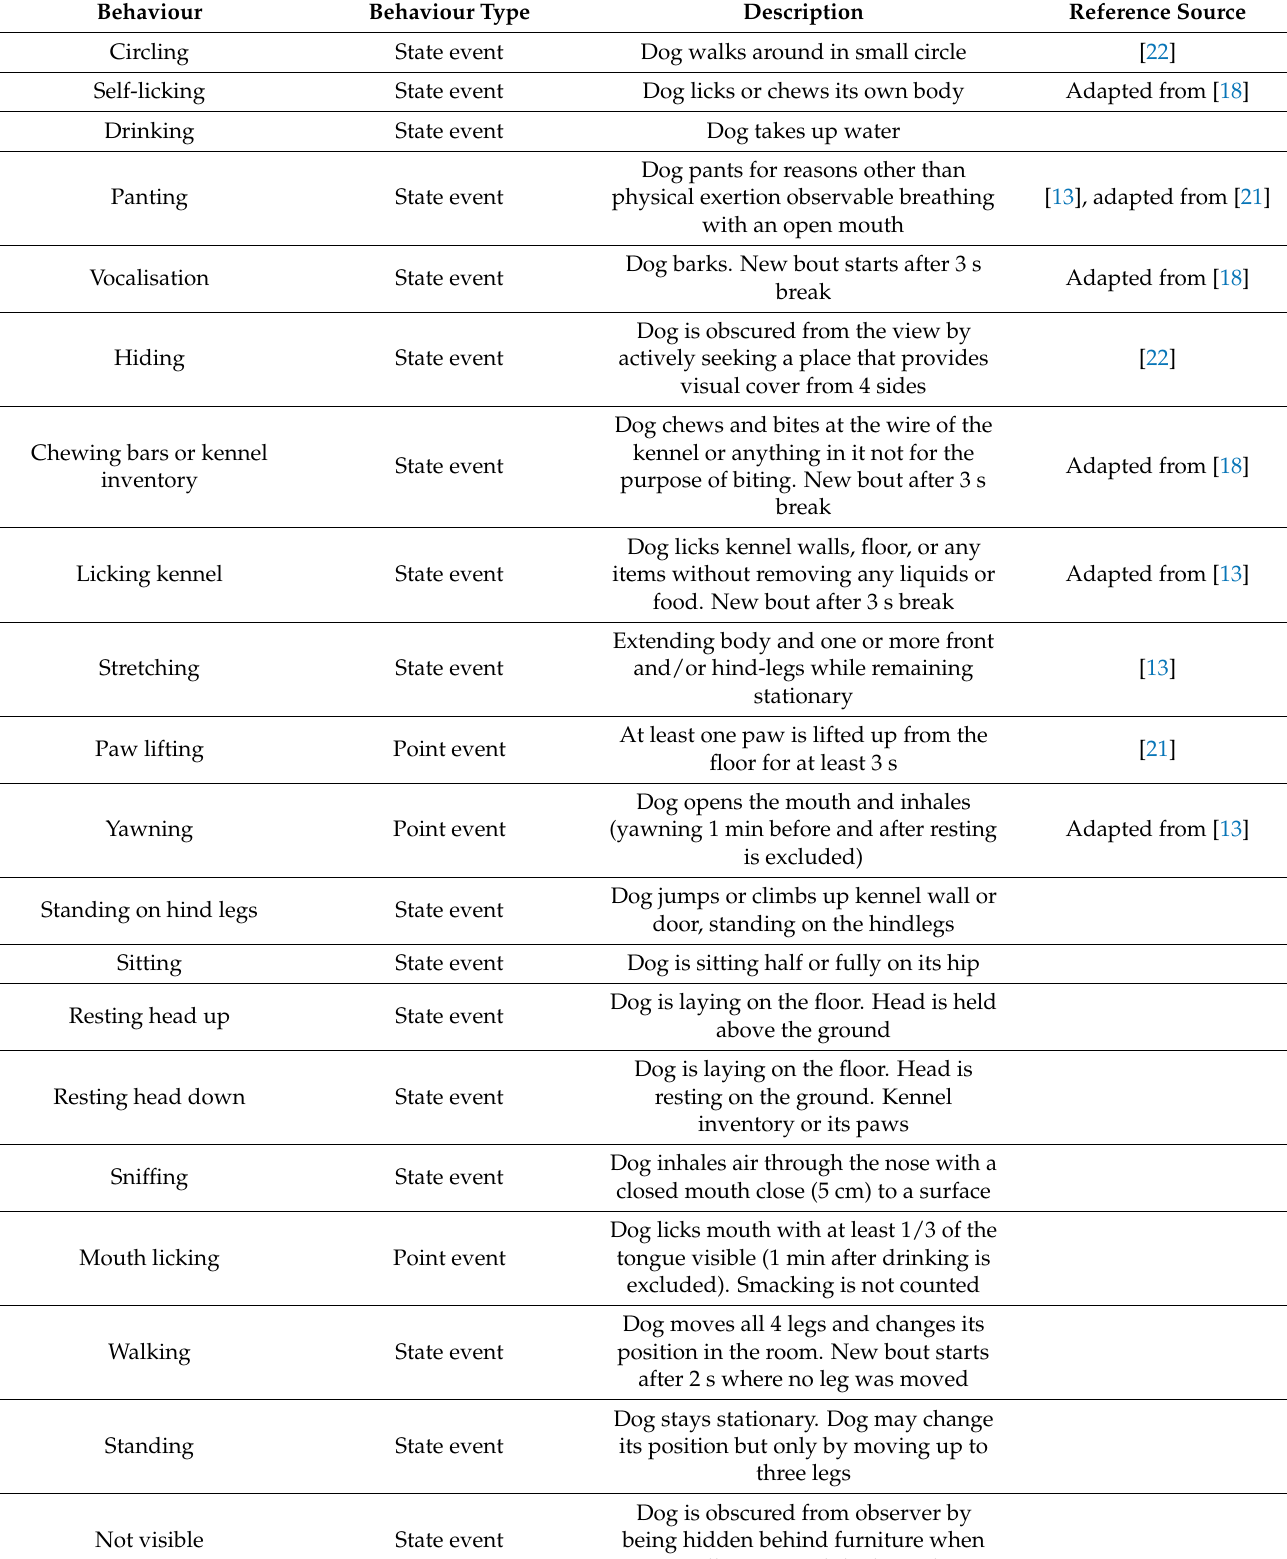
Table 1. Ethogram of the observed behaviours. For behaviour type “state event”, duration and frequency are recorded, whereas for behaviour type “point event”, only the frequency is